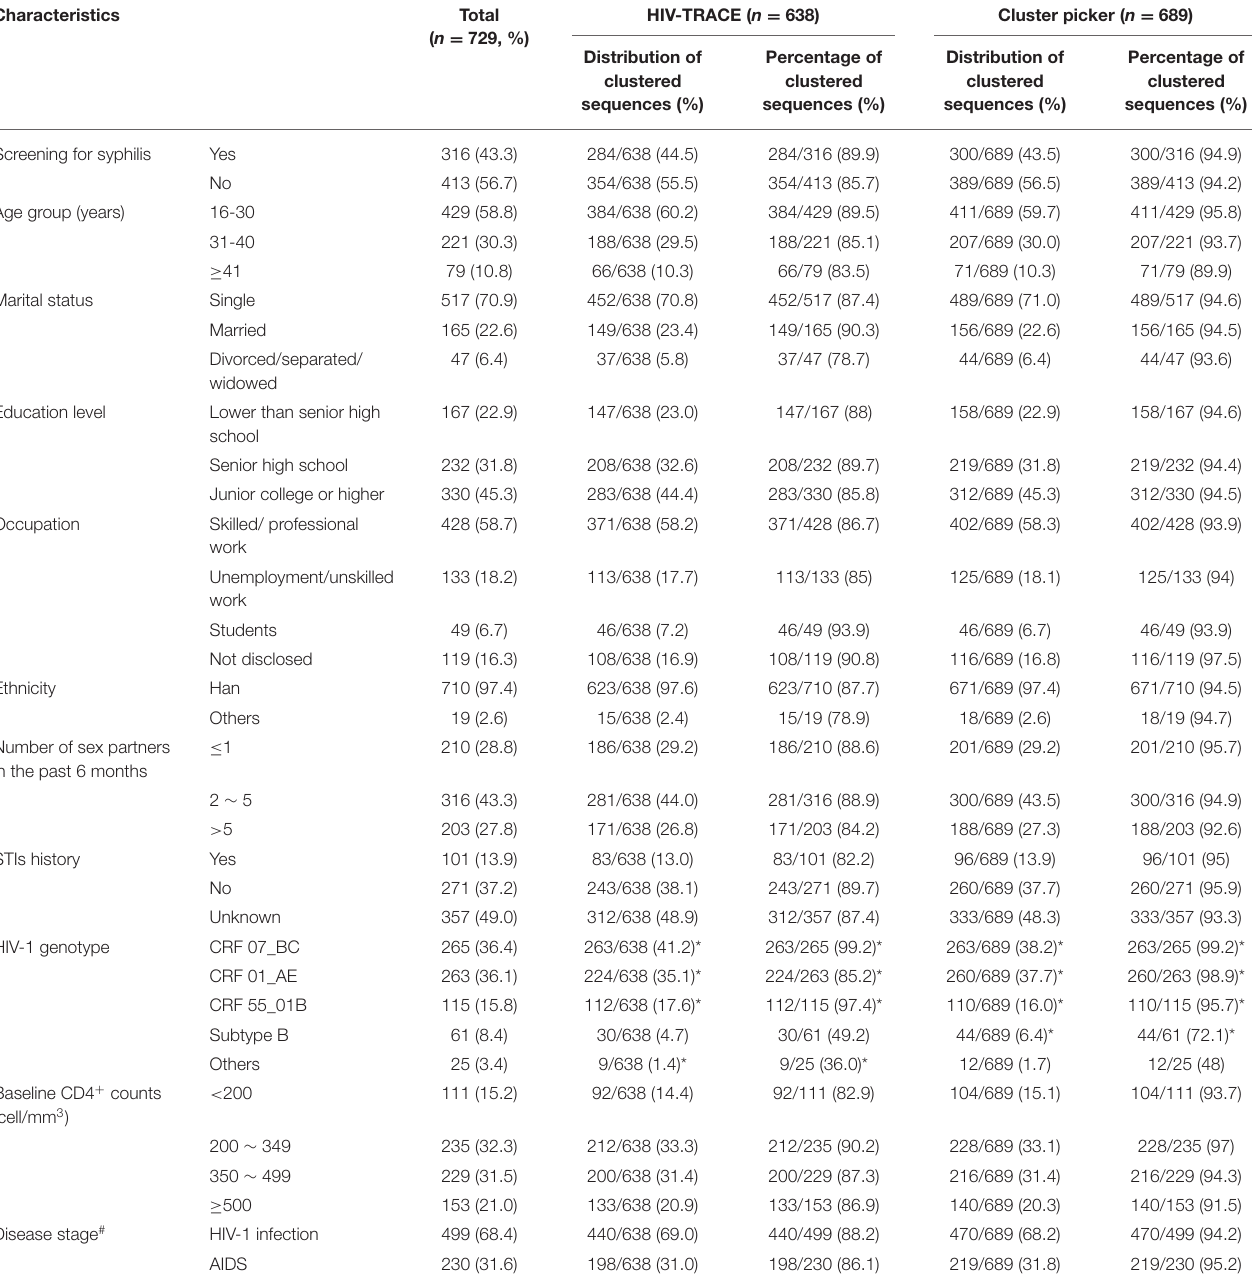
TABLE 1 | Demographic characteristics of HIV-infected MSM clustered by HIV-TRACE or Cluster Picker & .